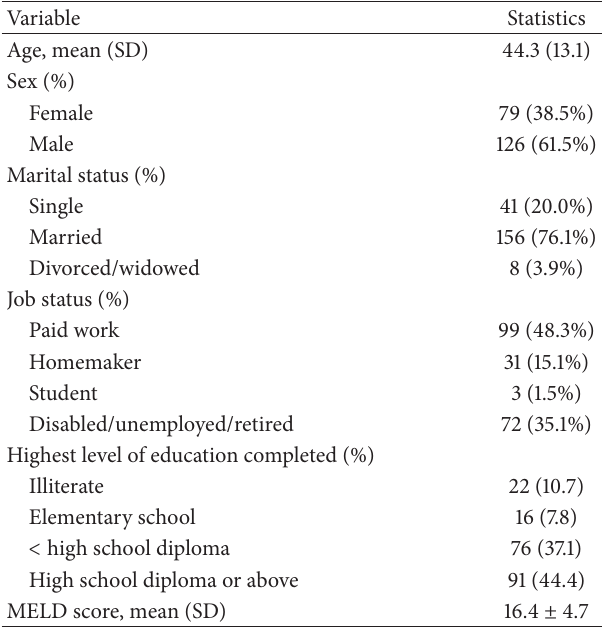
Table 1: Baseline characteristics of Iranian liver transplant candi- dates ( 𝑛 = 205